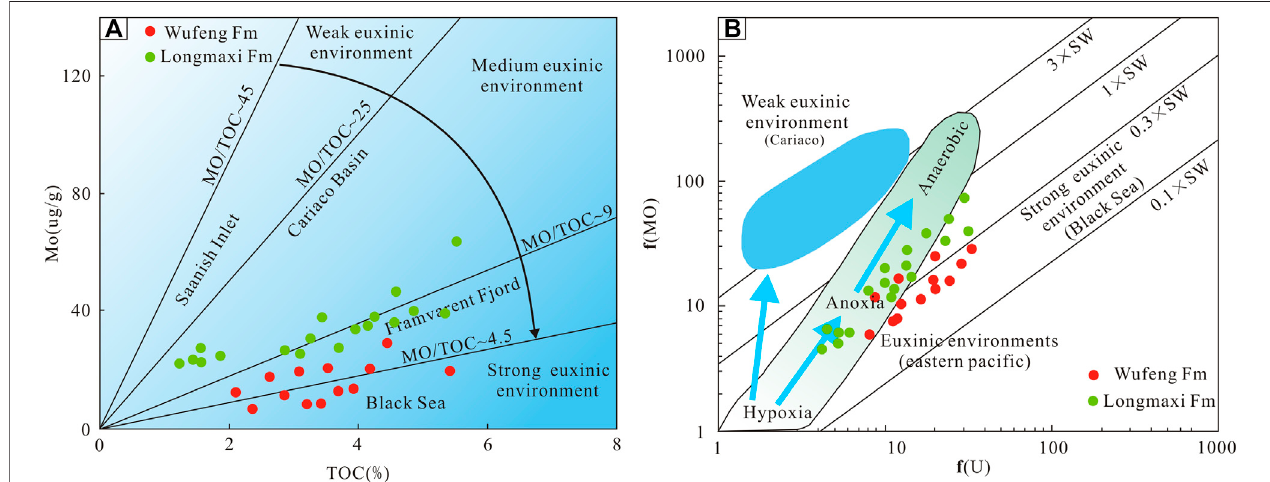
FIGURE 3 | Mo/TOC relationship of the Wufeng-Longmaxi Formation in southern Sichuan (A) and U-Mo covariant model; (B) . SW represents the Mo/U molar concentration ratio in seawater, SW (cid:1) 7.9.